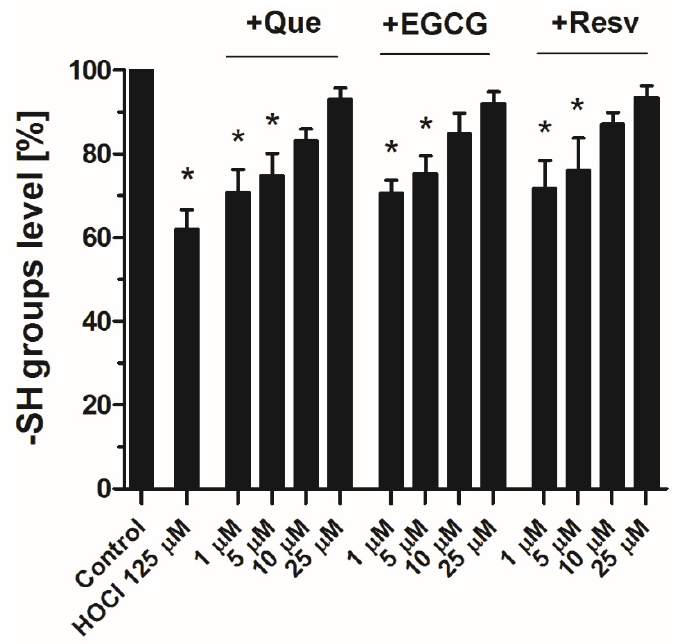
Figure 5. Effects of quercetin, epigallocatechin gallate and resveratrol on HOCl-produced decrease in free sulfhydryl groups in plasma. Samples of plasma were incubated for 10 min at 37 °C with HOCl (125 µ M) without (control) or with, preincubated or not with studied antioxidants (for 1 min) at indicated concentrations. The content of reduced thiol (-SH) groups in plasma was measured using the DTNB assay. The total free-SH group content in plasma was about 533.5 ± 83 µ M. Data are mean values ± S.D. from three independent experiments (each in triplicate). * p < 0.05.